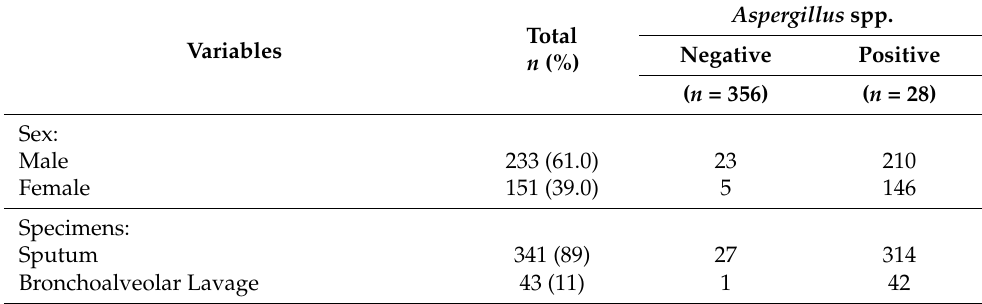
Table 1. Socio-demographic and clinical data of patients who participated in the study.